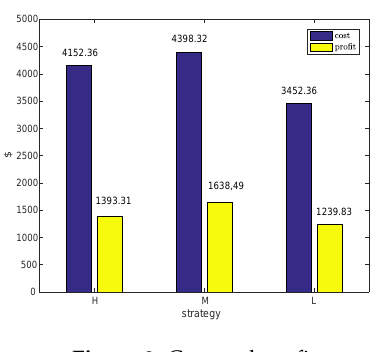
Figure 9. Cost and